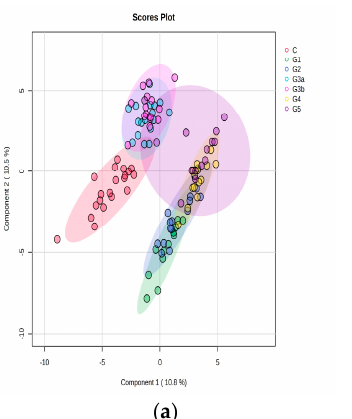
fi rst 15 molecules to be considered responsible for the discrimination, as presented in Fig- ure 2b. The cross-validation plot shows the low accuracy of the results: R2 values were higher than 0.1, but Q2 values were <0 for all components. By random forest analysis, we identified 15 molecules as potential biomarkers for CKD subgroups (Figure 2c).